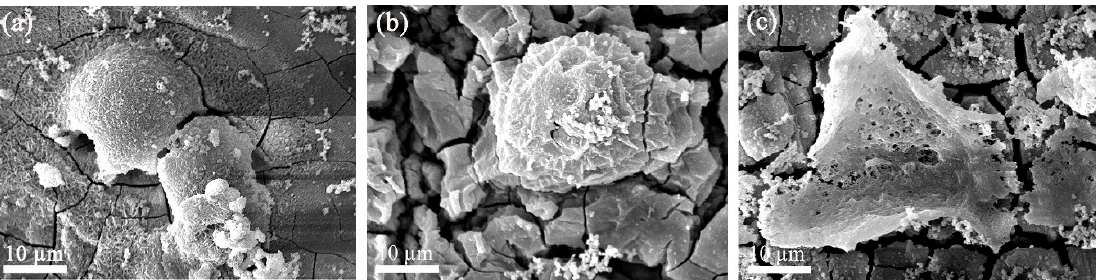
Figure 5. SEM micrographs of the adherent G292 cells, ( a ) “AZ31”; ( b ) “dopa”; and ( c ) “dopa-O” after 72 h of cultivation time.